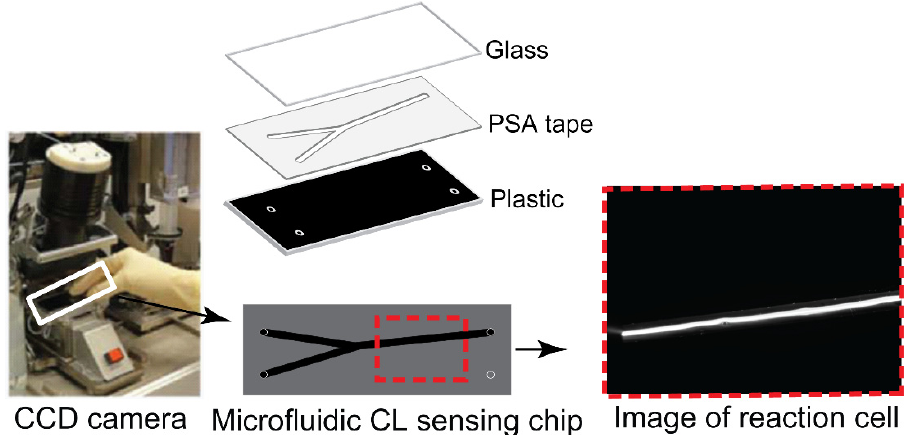
Figure 2. Microchip in CCD camera for CL was composed of glass, PSA tape and black plastic with holes for inlets and outlet. Images are taken by CCD camera when reaction occurs in micro- chip.